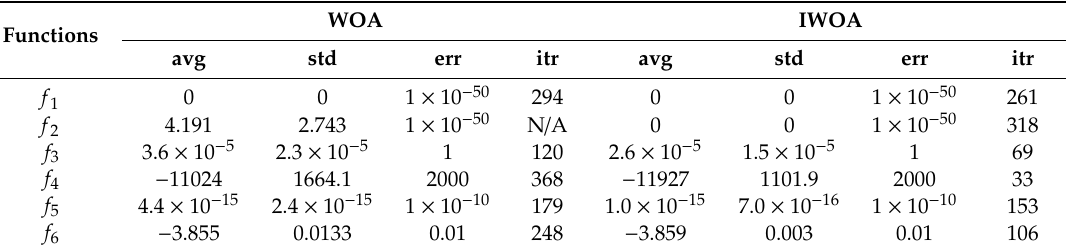
Table 2. Results of whale optimization algorithm (WOA) and